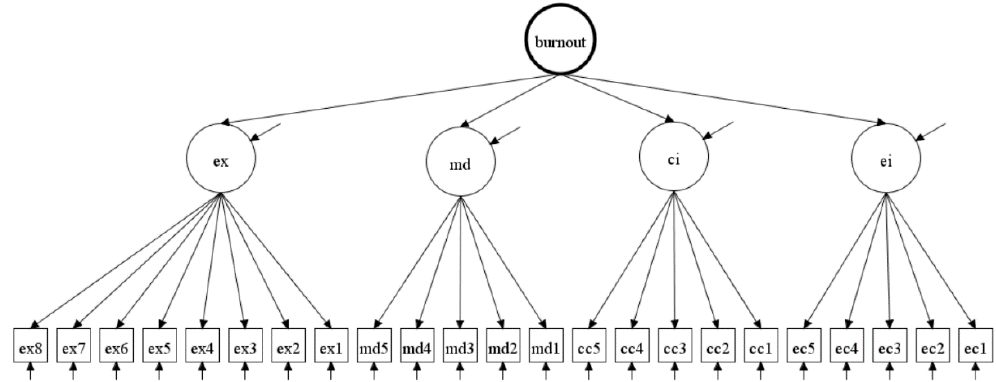
Figure 1. Thesecond-ordermodelofburnoutbasedontheconceptualizationoftheBAT.Note: ex = exhaustion, Figure 1. The second-order model of burnout based on the conceptualization of the BAT. Note: ex = md = mental distance, ci = cognitive impairment, ei = emotional exhaustion, md = mental distance, ci = cognitive impairment, ei = emotional impairment.